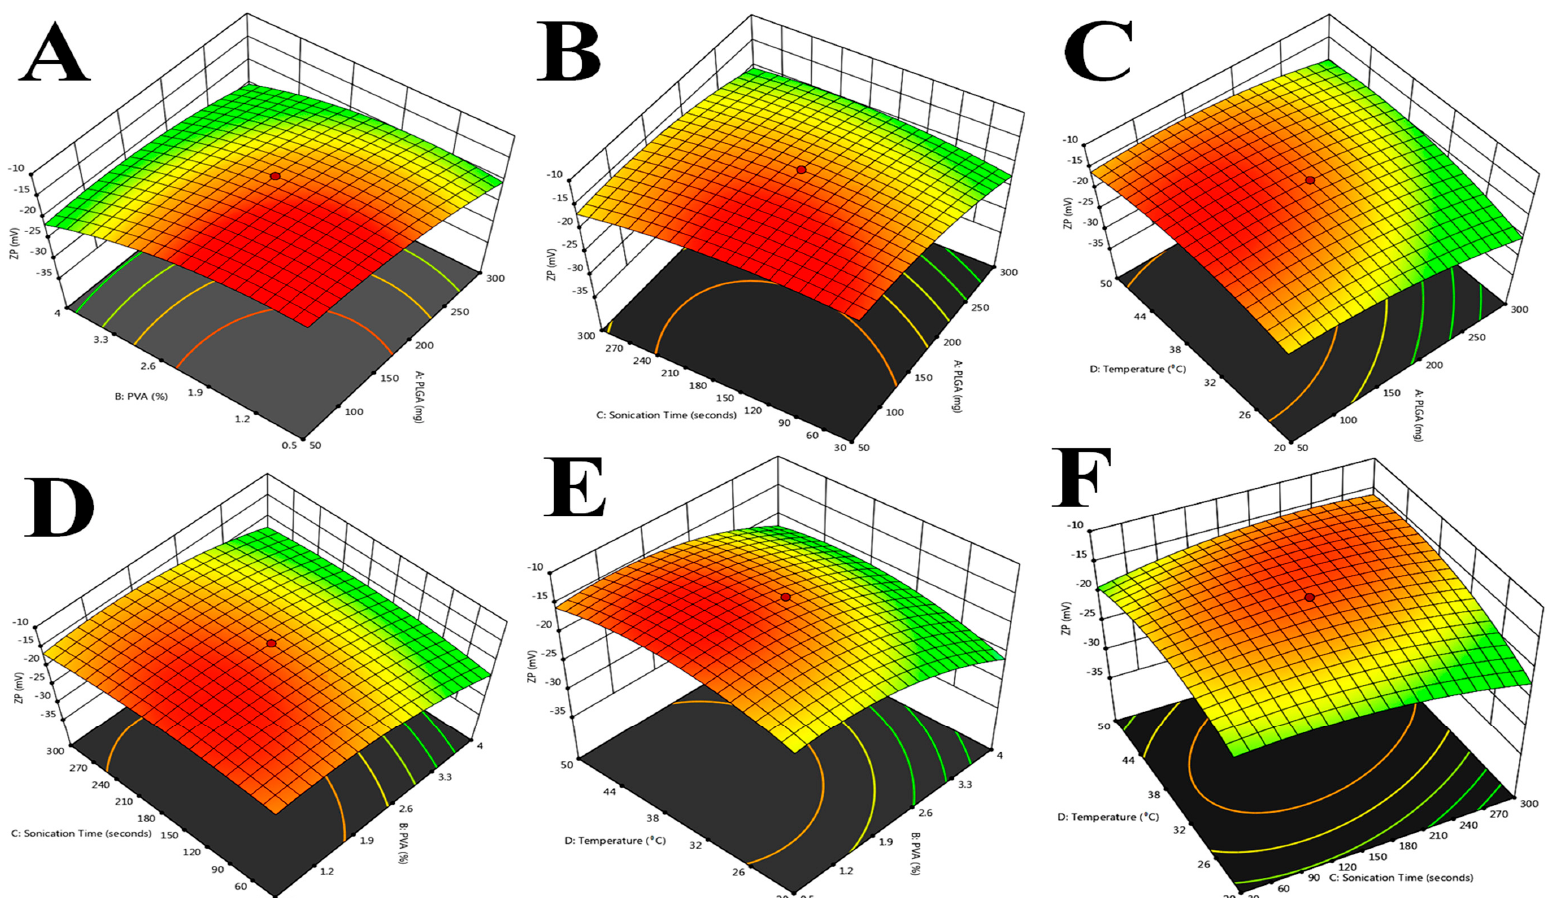
Figure 3. Response surface plot showing the effect of independent variables on Zeta potential (ZP). ( A ). Zeta potential, PVA (%), PLGA; ( B ). Zeta potential, sonication time, PLGA; ( C ). Zeta potential, temperature (°C), PLGA; ( D ). Zeta potential, sonication time, PVA (%); ( E ). Zeta potential, temperature, PVA (%); ( F ). Zeta potential, temperature, sonication time.